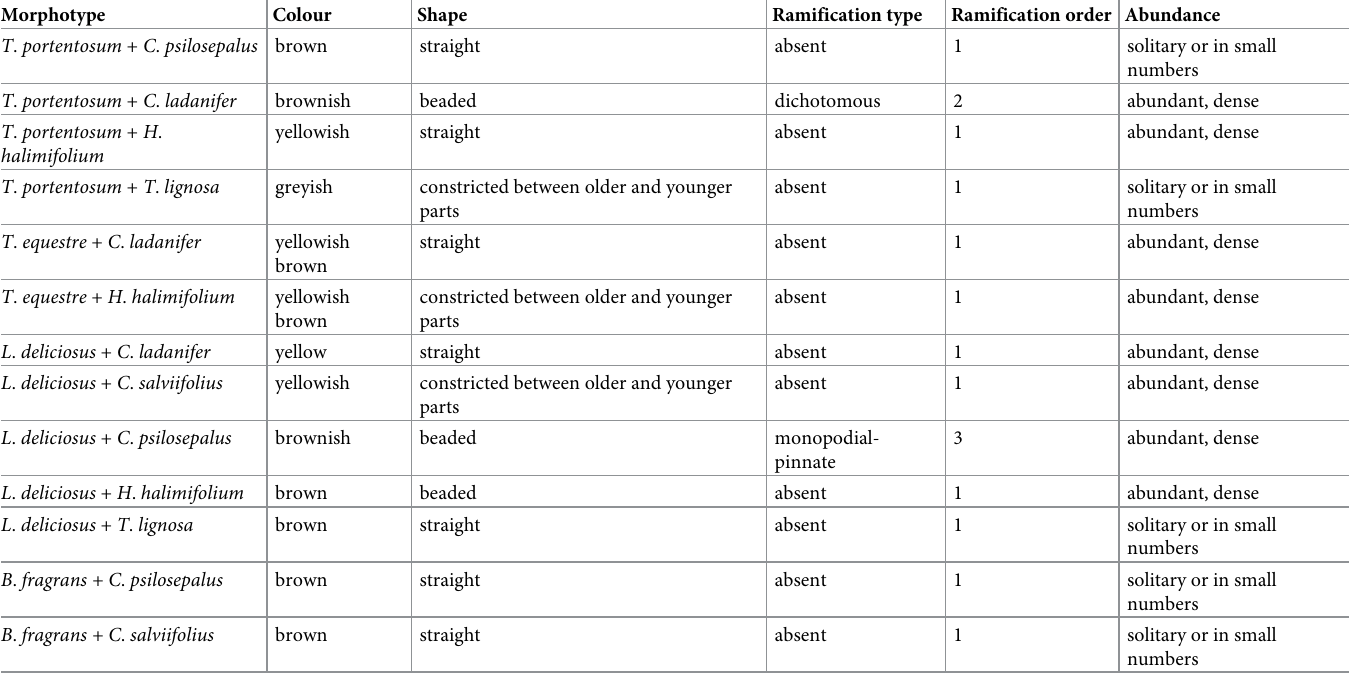
Table 3. Morphological description of ECM root tips from different plant-fungi combinations.